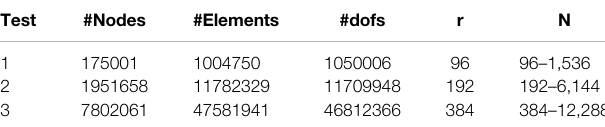
TABLE 2 | Mesh models for strong scaling test.